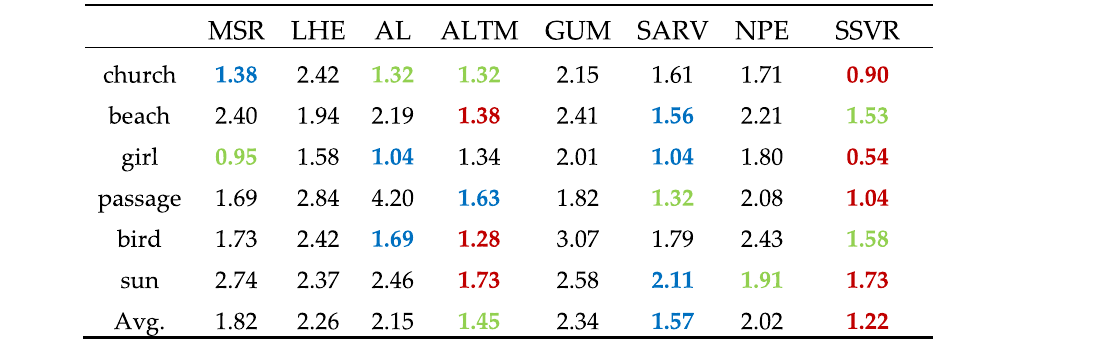
Table 3 COE values of compared methods